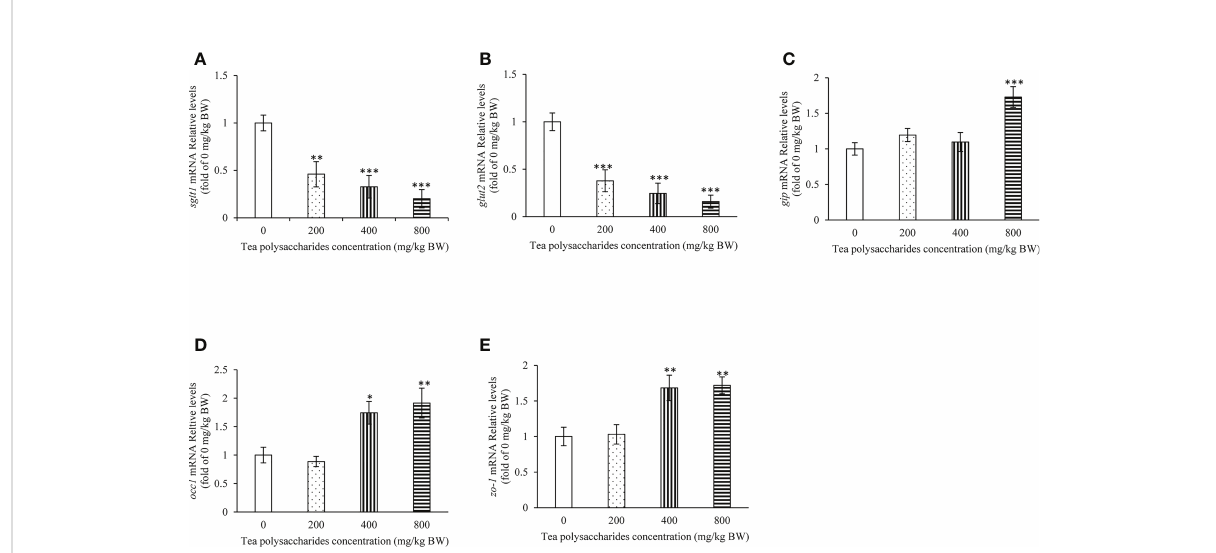
FIGURE 2 Effects of tea polysaccharides on genes expression related to glucose intake and gut barrier in foregut. (A) sglt1 ; (B) glut2 ; (C) gip ; (D) occ1 ; (E) zo-1 . At end of the experiment, fi sh were killed and the tissue was collected for RNA extraction and real-time PCR. All data are shown as mean ± S.E.M. (n = 10- 12). Signi fi cant differences were indicated by asterisks, *, P < 0.05; **, P < 0.01; ***, P <